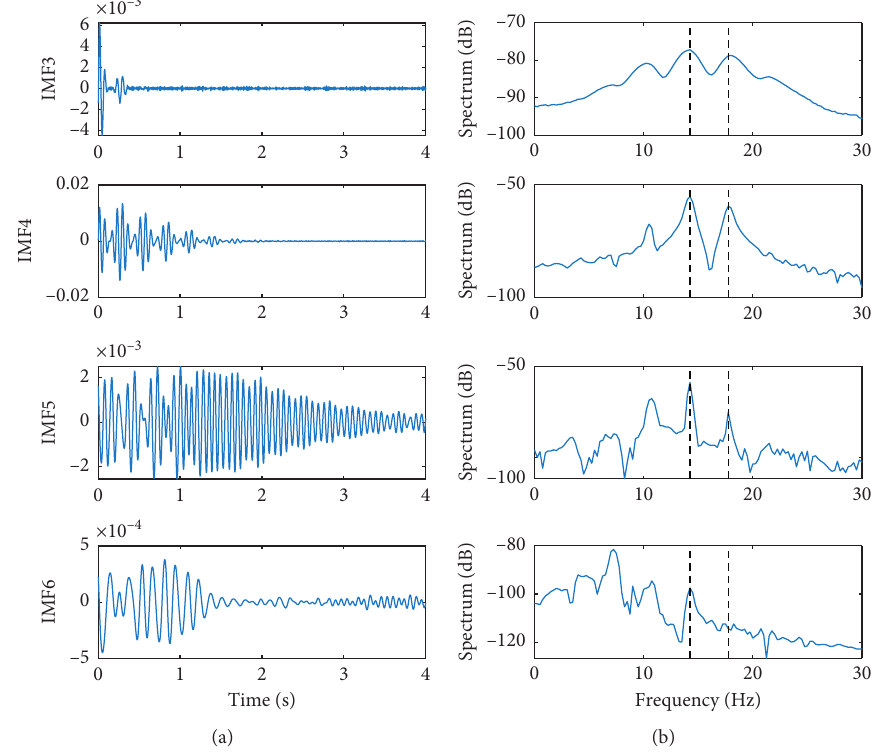
Figure 11: (a) The extracted four modes by CEEMDAN and (b) the corresponding Fourier